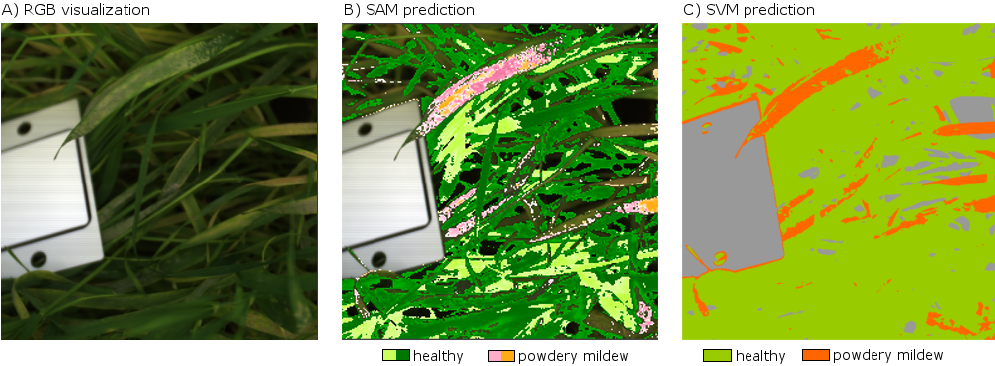
Figure 7. Classification of powdery mildew using the Spectral Angle Mapper (SAM) and Support Vector Machine (SVM). Powdery mildew detection with the SAM is based on two reference spectra for “symptoms” and two reference spectra for “healthy tissue”. The SVM prediction is based on 15 training samples for each class. The image contains the white reference panel on the left